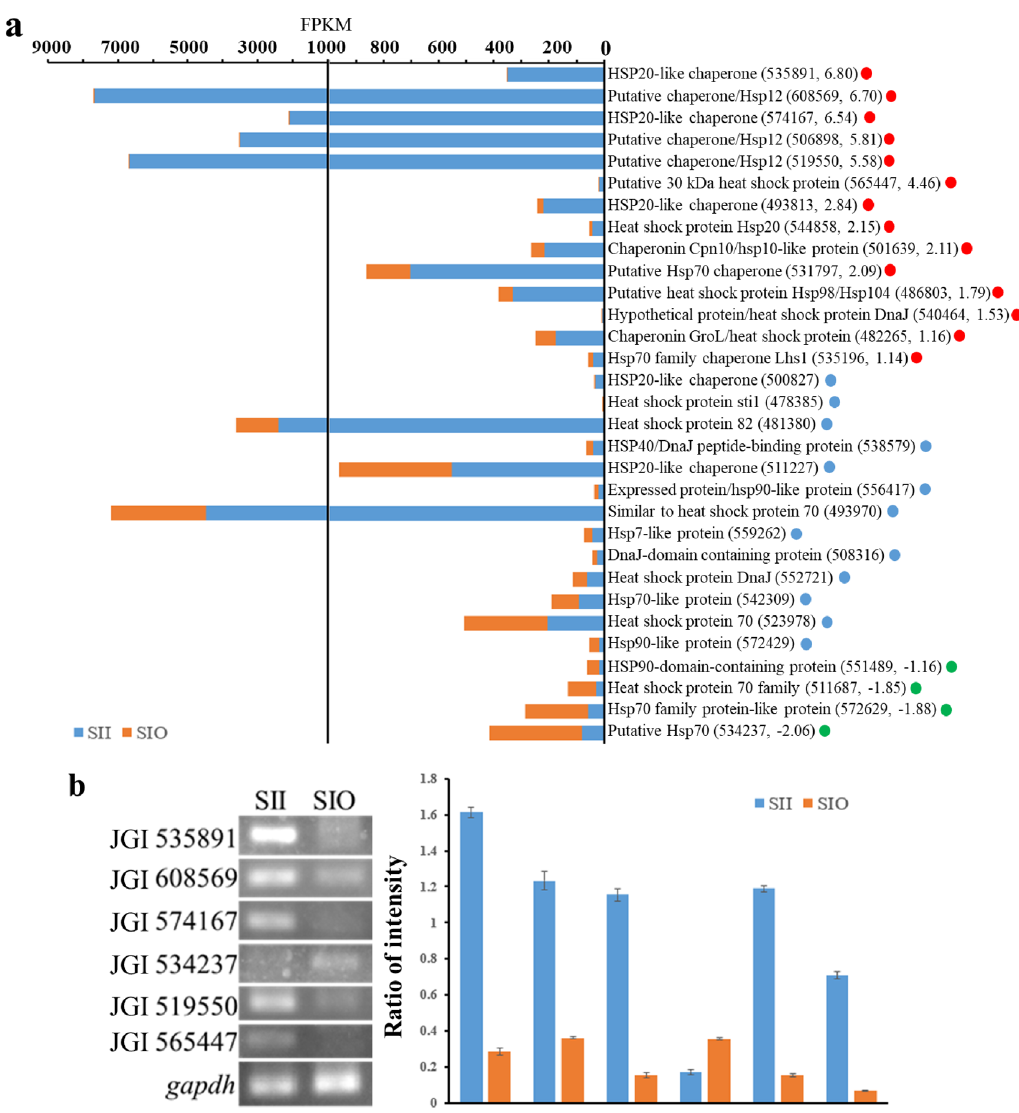
Figure 6. Expression levels of hsp genes. ( a ) FPKM of hsp genes in SII and SIO samples. Blue and orange bars indicate FPKM of genes in SII and SIO, respectively. Up-regulated genes were labeled as red dots followed by gene name, blue dots were non-DEGs, and down-regulated genes were labeled as green dots. The number in the bracket indicates the gene number of JGI log2 (Fold Change) value. ( b ) Expression of several hsp genes verified by RT-PCR. Constitutive gapdh served as the control. Intensity ratio indicated hsp gene expression versus gapdh expression. Error bars indicate standard